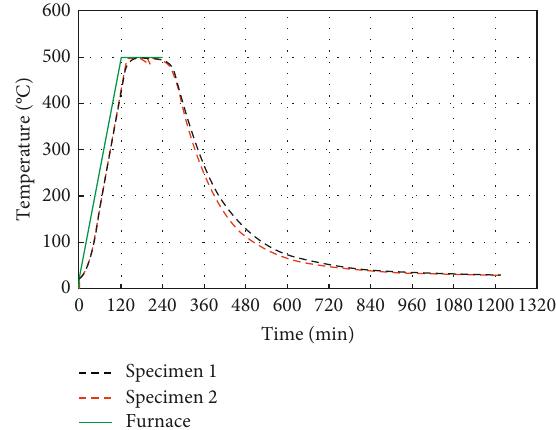
Figure 4: Typical measurement of the temperatures at the cores of the concrete